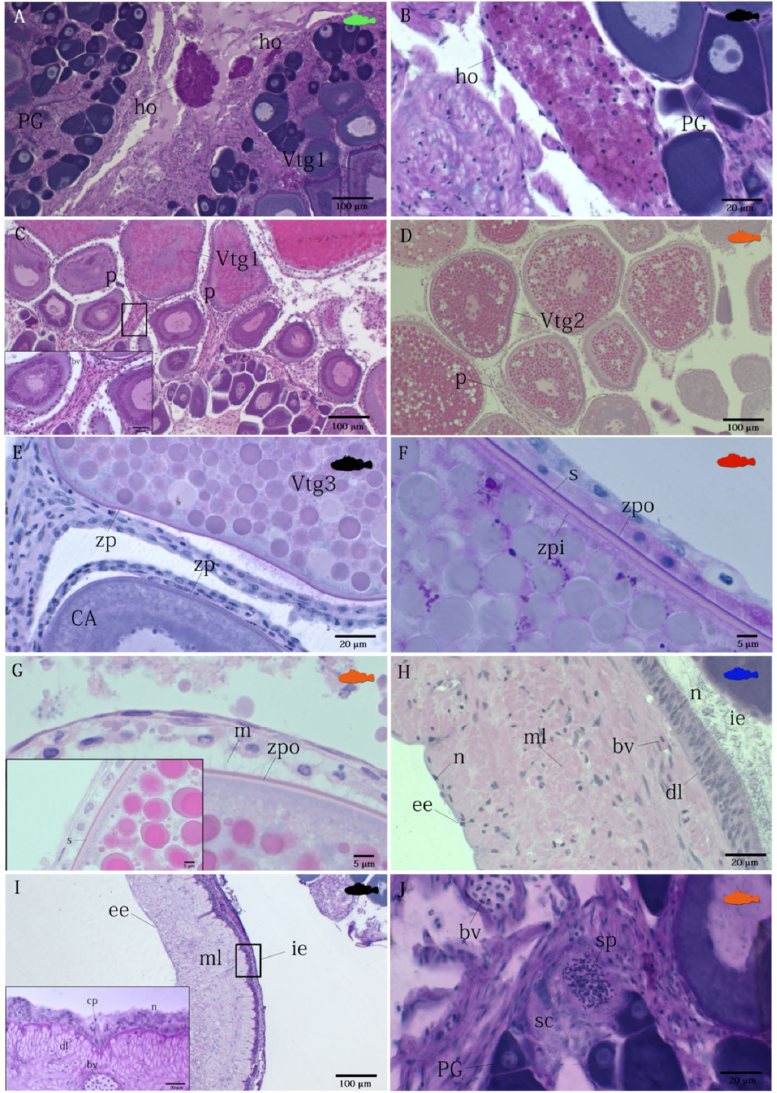
Figure 2. Photomicrographs of ovarian histology, depicting: ( A ) Scorpaena elongata , cross section of a maturing ovary in which holocrine glands, reacting positively to PAS staining, are present (AB/PAS). ( B ) Scorpaena porcus , high magnification of an holocrine gland PAS-positive (AB/PAS); connected to the stroma by a branching, vascularized peduncle (H&E); ( D ) Helicolenus dactylopterus , a